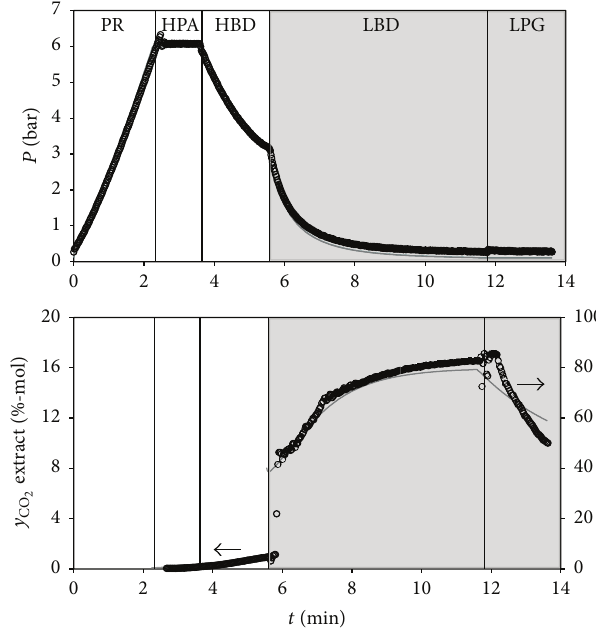
Figure 8: Comparison between the predicted (lines) and the experimental (symbols) pressure and CO 2 effluent composition histories for a PSA run at CSS employed for the separation of CO 2 / N 2 30 :70% (-mol) mixture at 309 K, 𝑃 H = 6 bar, 𝑃 L = 0.4 bar, feed flow rate of 3.0 slpm, and a total feed/cycle of 10.75 L STP (STP: 273 K, 1atm) [23]. White area denotes cocurrent operation with raffinate (N 2 ) production, whereas grey area reflects the counter- current operation with extract (CO 2 )